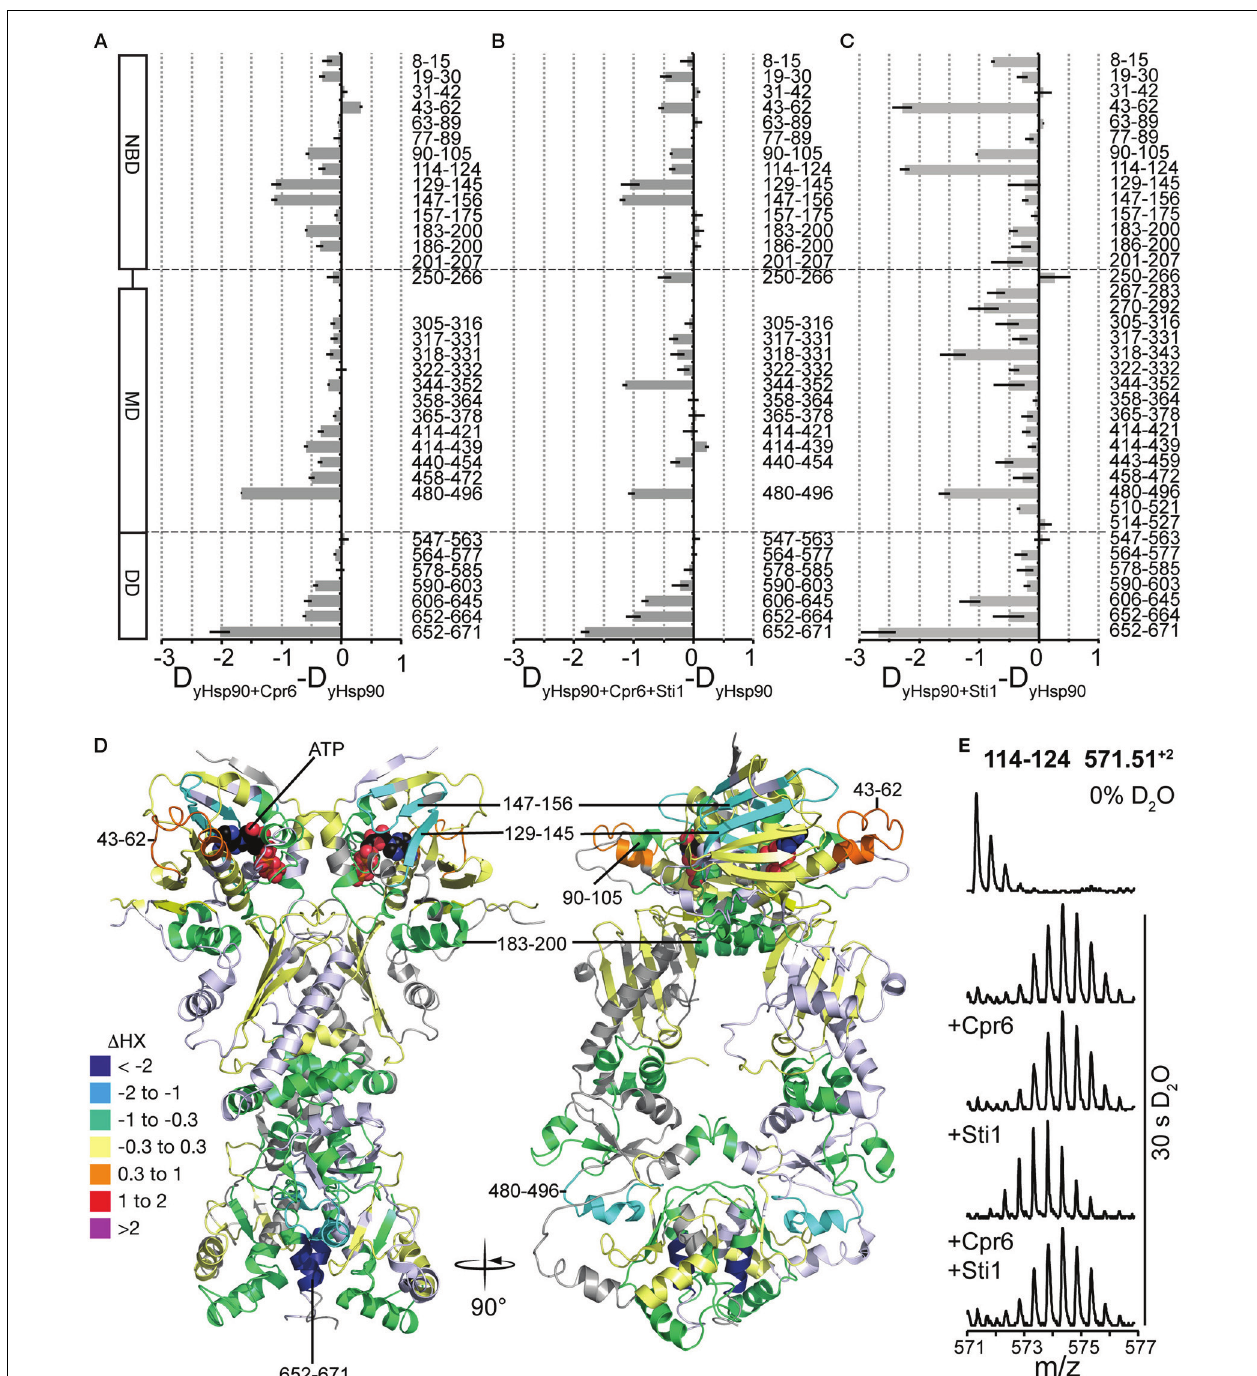
FIGURE 7 | Effects of Cpr6 and Sti1 on the conformational dynamics of yHsp82. (A) Difference plots of deuterons incorporated into yHsp82 in the presence of Cpr6minus deuteron incorporation in the absence of Cpr6 after 30s HX. The numbers to the right indicate the corresponding peptic peptides, the domain structure is shown to the left. Error bars represent standard error of three independent experiments. (B) Difference plots of deuterons incorporated into yHsp82 in the presence of Cpr6 and Sti1minus deuteron incorporation in the absence of Cpr6 and Sti1 after 30s HX. (C) Difference plots of deuterons incorporated into yHsp82 in the presence of